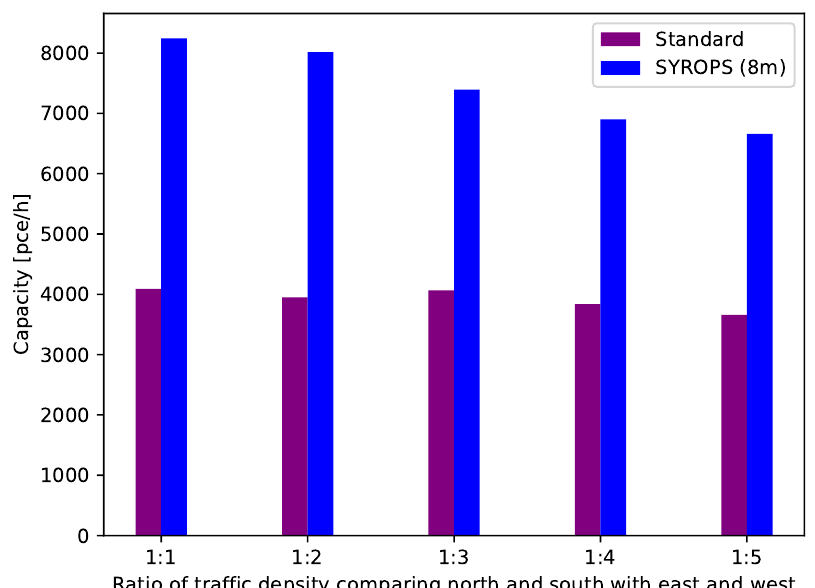
Figure 19. Roundabout capacity in vehicles per hour depending on the level of unbalance ratio between orthogonal directions (N–S vs. E–W).